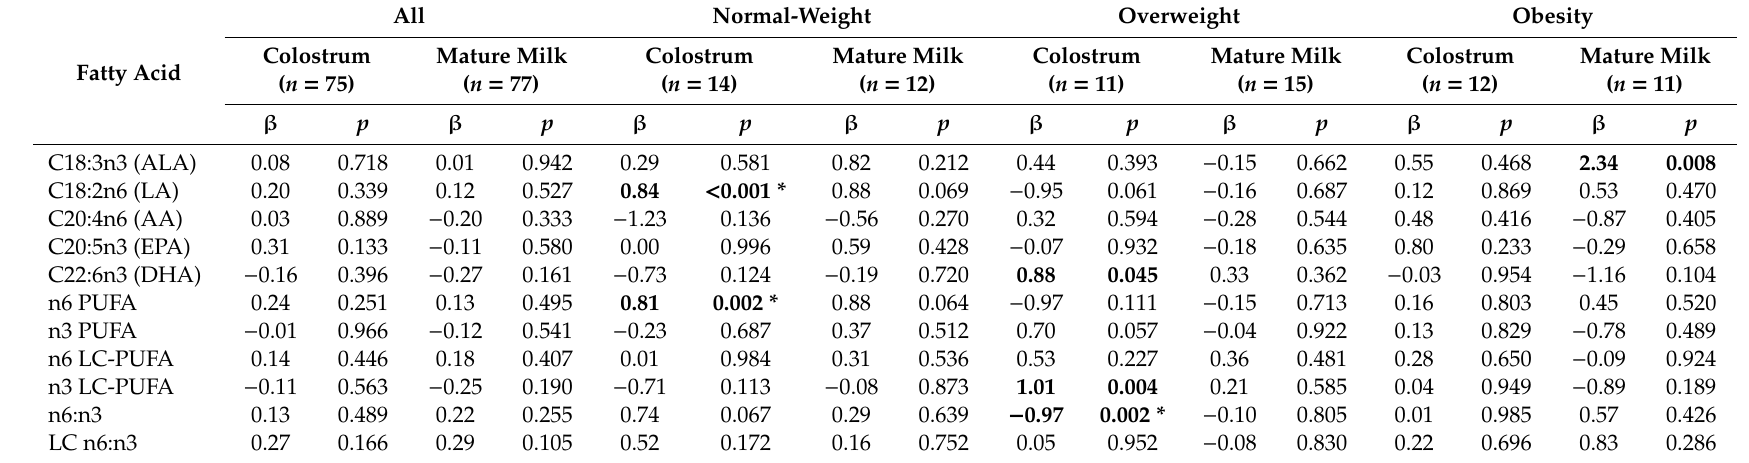
Table 4. Associations between breast milk PUFA levels and infant cognition score at 18 months of age, according to maternal pre-pregnancy BMI. All Normal-Weight Overweight Fatty Acid